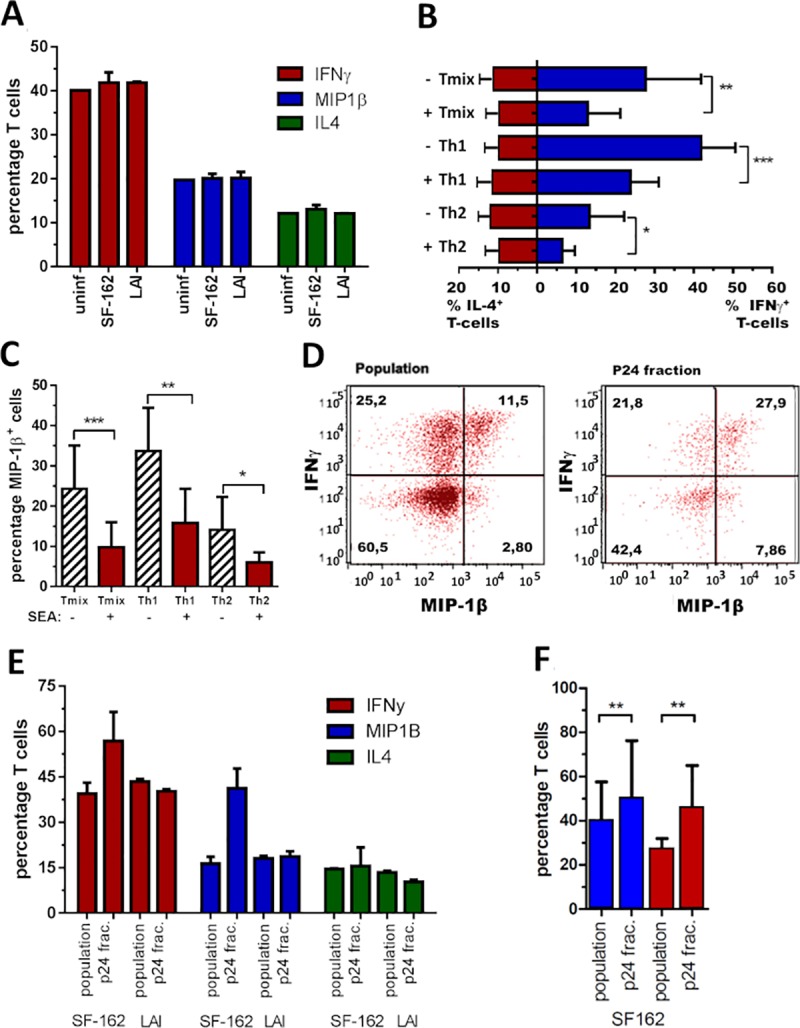
DCs exposed to SEA, induce T-cell cultures with less IFN-γ and MIP-1β producing T-cells.(A) Percentage of Tmix-cells producing IFN-γ, MIP-1β and IL-4 in an uninfected (bar 1), SF162 (bar 2) or LAI (bar 3) infected T-cell population., Representative for Tmix, Th1 and Th2 cell cultures induced by DCs matured either in absence or presence of SEA. (B) Plotted is the average percentage of IL-4 and IFN-γ producing T-cells in Tmix, Th1 and Th2 cell cultures induced by DCs matured either in absence or presence of SEA. (C) Average percentage of MIP-1β producing T-cells in the three T-cell populations induced by DCs matured in absence or presence of SEA. (D) Dot-plot of IFN-γ (y-axis) and MIP-1β (x-axis) producing Th1 cells in the SF162 population (left) and the p24+ fraction of that population (right) shown in the next panel. (E) Percentage of IFN-γ, MIP-1β and IL-4 producing T-cells in a SF162 or LAI infected Th1 cell culture (bar 1 and 3) versus the percentage found in the p24+ fraction (bar 2 and 4). (F) Data of 7 independent experiments combined depicting the percentage of IFN-γ and MIP-1β producing T-cells in a SF162 infected Th1 cell population versus the percentage found in the p24+ fraction of that population. Both Figs (E and F) are representative for all three T-cell populations induced by DCs matured either in absence or presence of SEA. (A, D, E) Representative figures from at least 5 experiments (conditions with virus were performed in duplicate) while (B, C, F) are the results of 6 to 8 independent experiments using at least 5 donor combinations combined, depict are the mean value and SD. *p<0.05 **p<0.01 ***p<0.001.